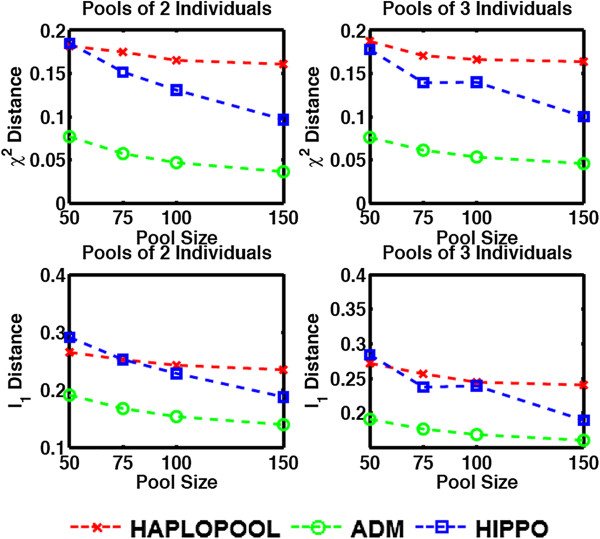
Measures of performance of HAPLOPOOL, HIPPO and ADM applied to the AGT gene dataset.